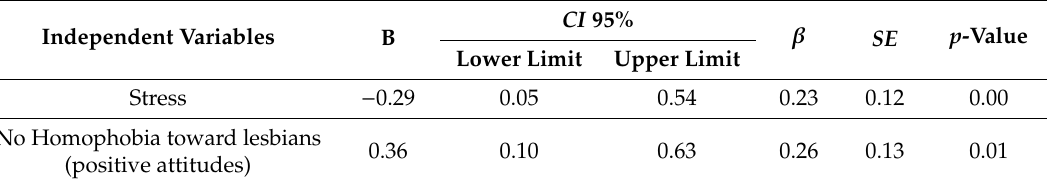
Table 4. Regression of “attitudes toward gender equality” for the variables homophobia toward gays and lesbians, self-esteem, emotional intelligence, empathy, levels of everyday stress, and resilience in university students.